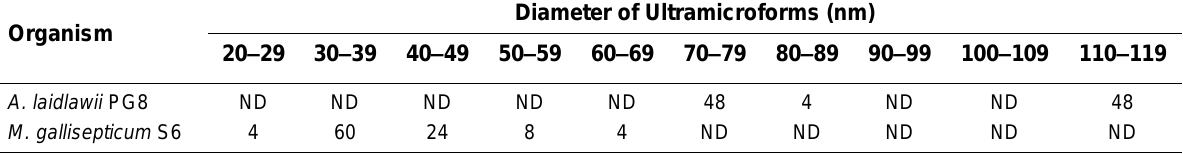
The Percentage of Ultramicroforms with the Definite Sizes Found in A. laidlawii PG8